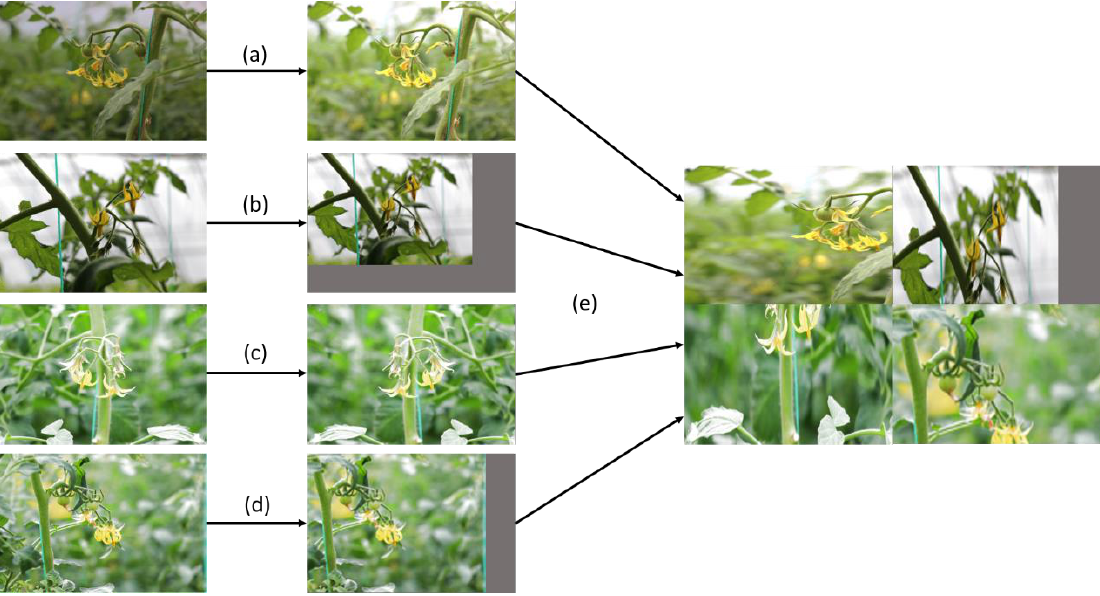
Figure 3. Data augmentation methods: ( a ) gamut adjustment; ( b ) random scaling; ( c ) horizontal mirroring; ( d ) panning; and ( e ) mosaic.